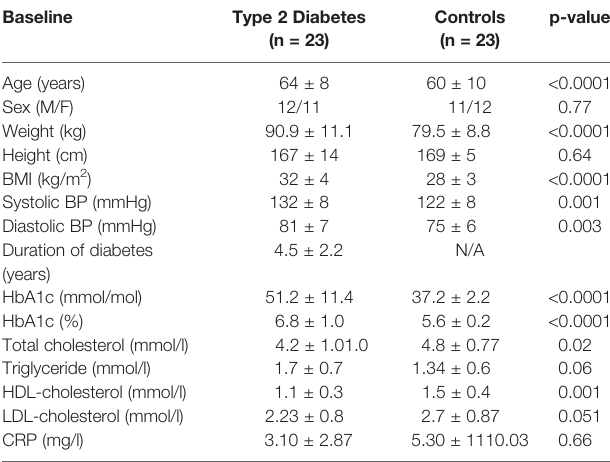
( Figure 2B ). When T2D subjects were strati fi ed according to ACE inhibitor (ACEi) therapies, there was no difference in sNRP1 levels in subgroups at either glucose normalization or hypoglycaemia ( Figure 2C ). sNRP1 did not correlate with any of the renin angiotensin system (RAS) proteins measured here: ACE2, REN or AGT ( Figure 3 ).